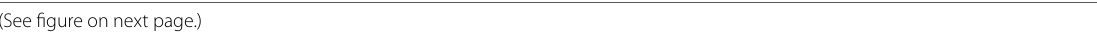
figure on next Fig. 21 Reduced consensus cladograms of basal sauropodomorph relationships resulting from a phylogenetic analysis of 382 characters scored for 66 taxa (see text for details), showing the phylogenetic position of Schleitheimia . a Maximum parsimony analysis using equal weights. b Maximum parsimony analysis using implied weights (k 12). Numbered nodes: 1, Sauropodomorpha; 2, Plateosauridae; 3, Massopoda; 4, Massospondylidae; 5, = Sauropodiformes; 6,